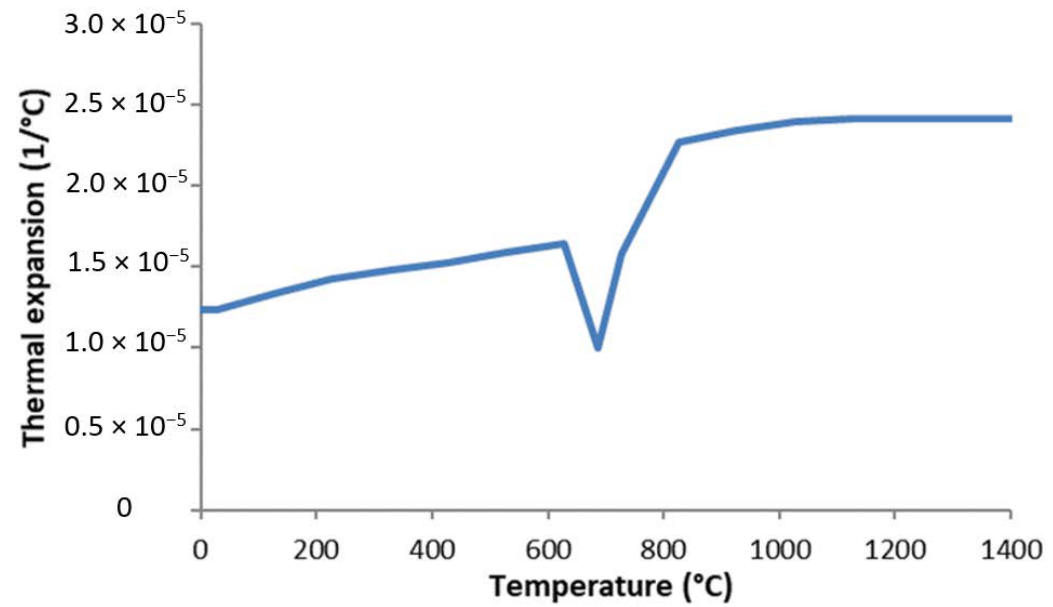
Figure 10. Thermal expansion coe ffi cient used in reference simulations for